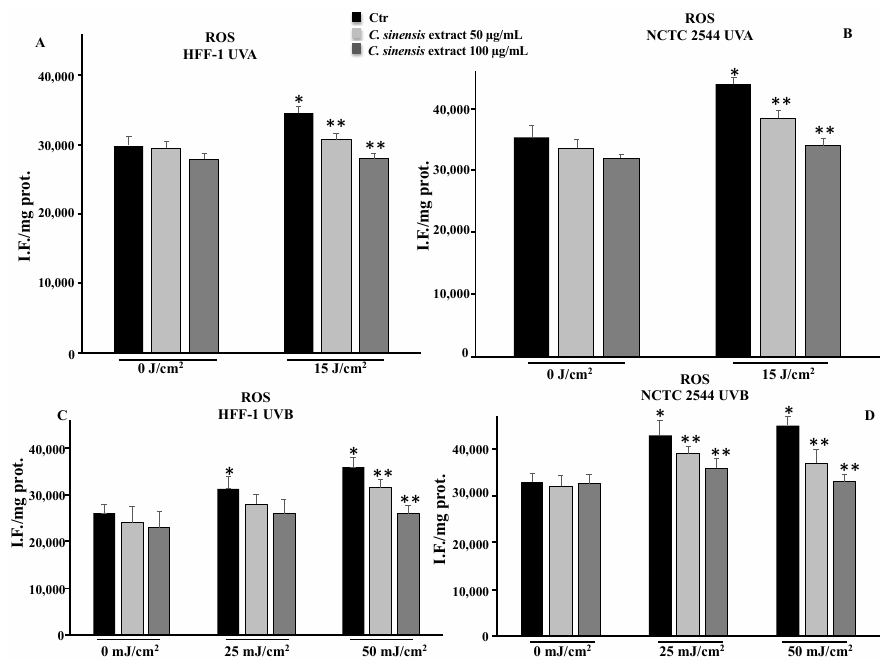
Figure 6. ROS levels in HFF-1 ( A , C ) and NCTC 2544 ( B , D ) cells untreated (Ctr) and treated for 4 h with C. sinensis extract at different concentrations (50–100 µg/mL) and irradiated with 15 J/cm 2 of UVA and/or with 25 mJ/cm 2 or 50 mJ/cm 2 of UVB. Values are the mean ± S.D. of four experiments in triplicate. * Significant vs. untreated control cells: p < 0.001; ** Significant vs. untreated irradiated cells: p < 0.001.